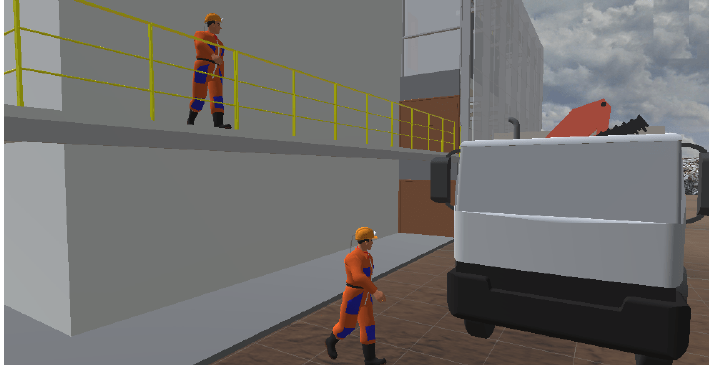
Figure 4. A worker in a safe situation on the top and another in a hazardous situation on the